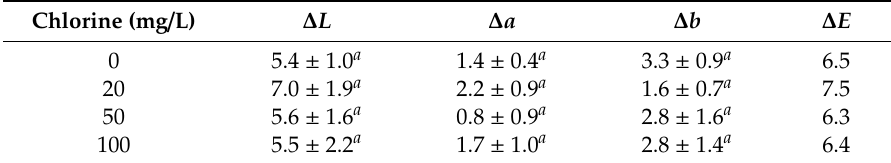
Table 5. Changes in the color of chicken breasts treated with different chlorine concentrations. Chlorine (mg/L)